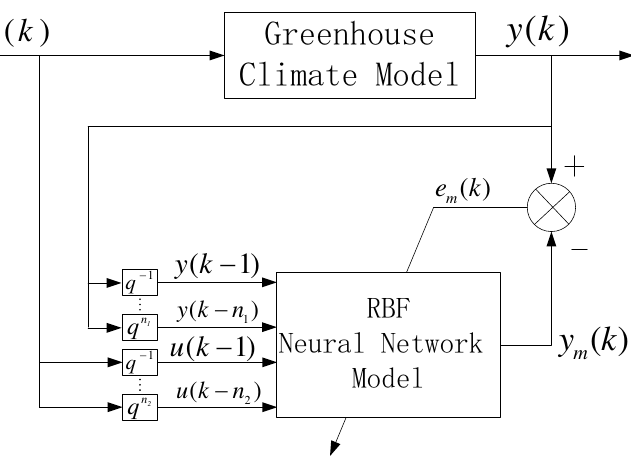
Figure 4. Process identification based on RBF